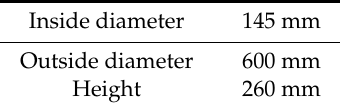
Table 1. 6 polarity electromagnetic system.